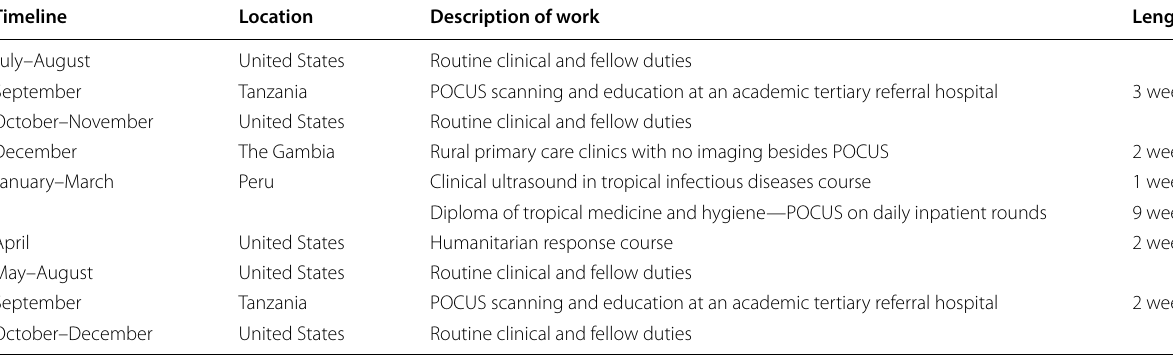
Table 2 Summary of a fellow’s international and domestic work